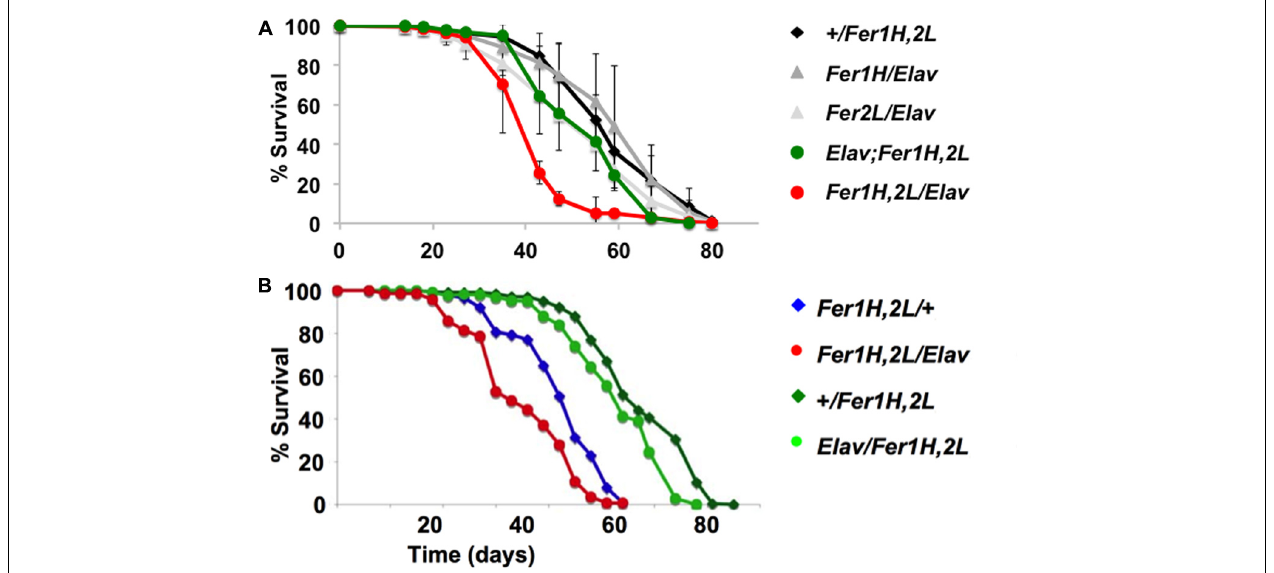
experiments. Note the early onset of mortality in the flies overexpressing ferritin from the X-chromosomal recombinant. (B) A similar single experiment demonstrating that a maternal component determines the early onset mortality. Note that the same genotypes have markedly different lifespans, whose length is predicted by the mothers used for the crosses (see text for details). Overexpression of ferritin was never seen to have a beneficial effect on lifespan.